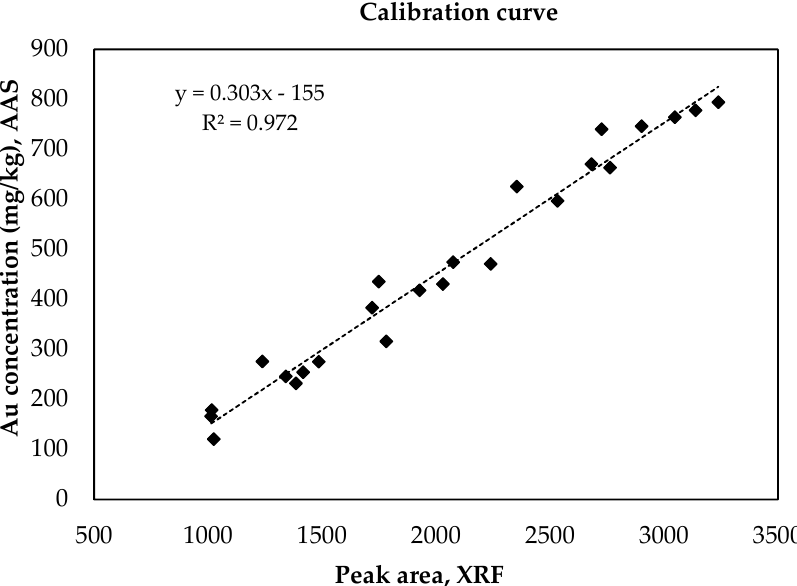
Figure 3. Calibration curve for FPXRF obtained by using real samples of PCBS as standards (number of standards: 24).